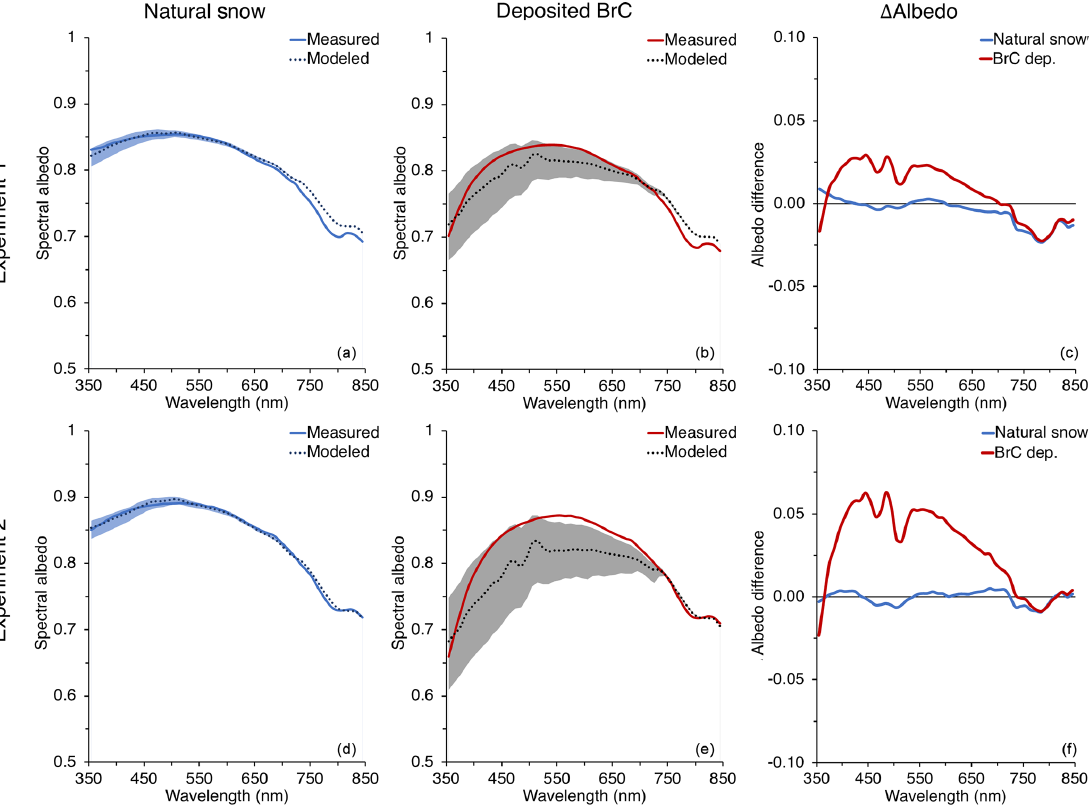
Figure 8. Comparisons of measured and modeled spectral albedos and their differences for Experiment 1 (a, b, c) and Experiment 2 (d, e, f) . The left column shows modeled and measured albedo of the natural snowpack at Tamarack Lake, NV. The middle column shows the measured albedo compared to SNICAR-calculated albedo by adding concentrations of deposited BrC into the model. The right column represents the difference between the measured albedo and the mean modeled albedo for the natural snow and deposited BrC. The range of modeled albedos from the range of κ BrC retrievals for BrC deposited is represented by shaded regions in the left and middle